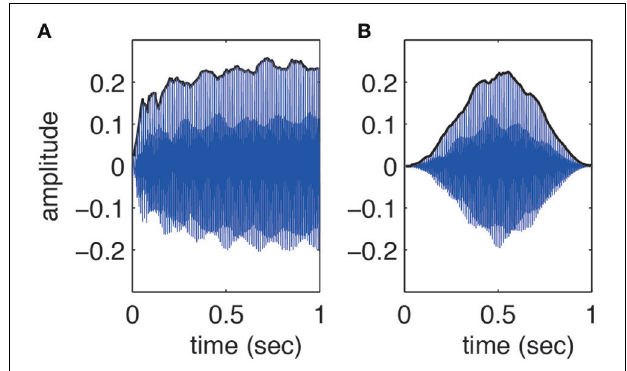
FIGURE 1 | The waveform of the sound derived from Cello with fundamental frequency of 100Hz (A) before and (B) after having been manipulated with a Hanning window. Hanning window is a bell-shaped weighting function which makes the sound’s onset and offset symmetrical. However, the harmonic structure of the sound is